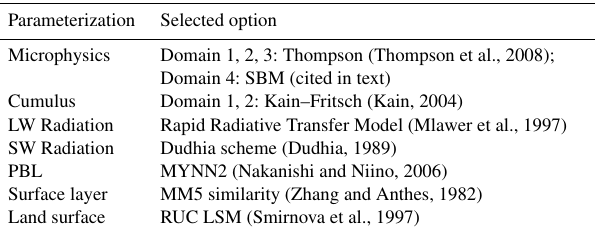
Table 1. WRF model parameterizations selected for use in study